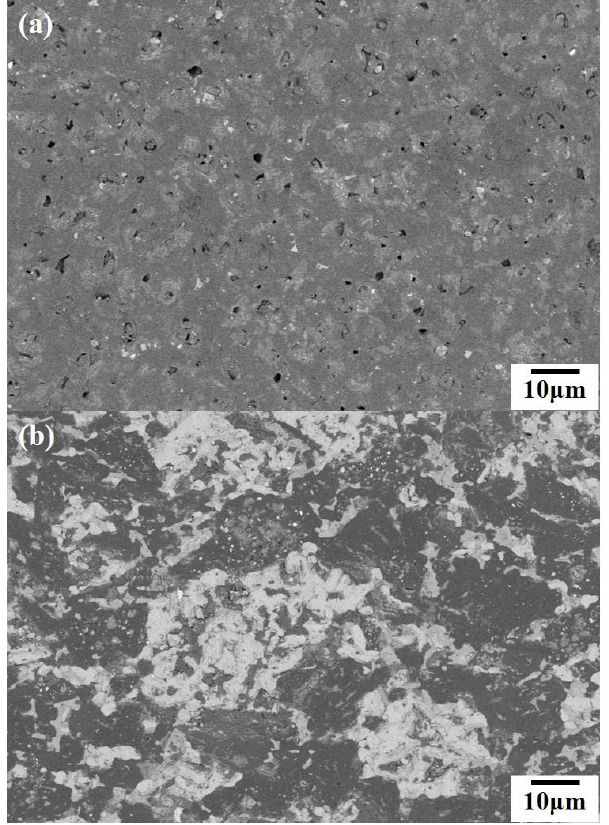
Figure 3. ( a ) BSE image of BT0; ( b ) BSE image of BT30.